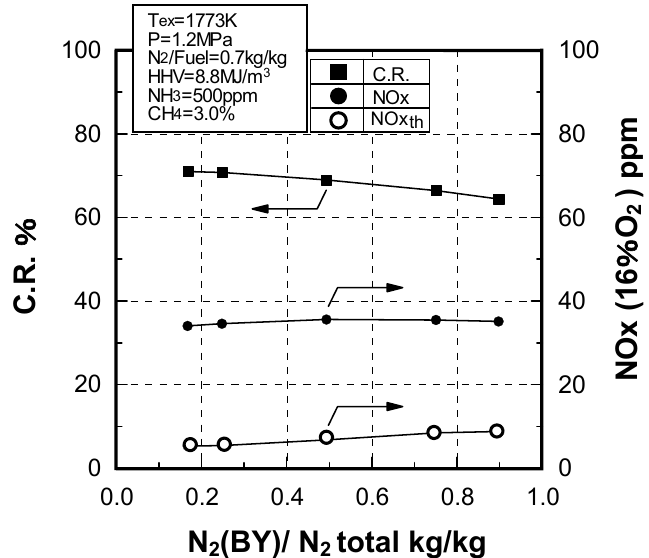
Figure 80. Effect of bypassing nitrogen flow rate, premixed with combustion air on NOx emission characteristics.